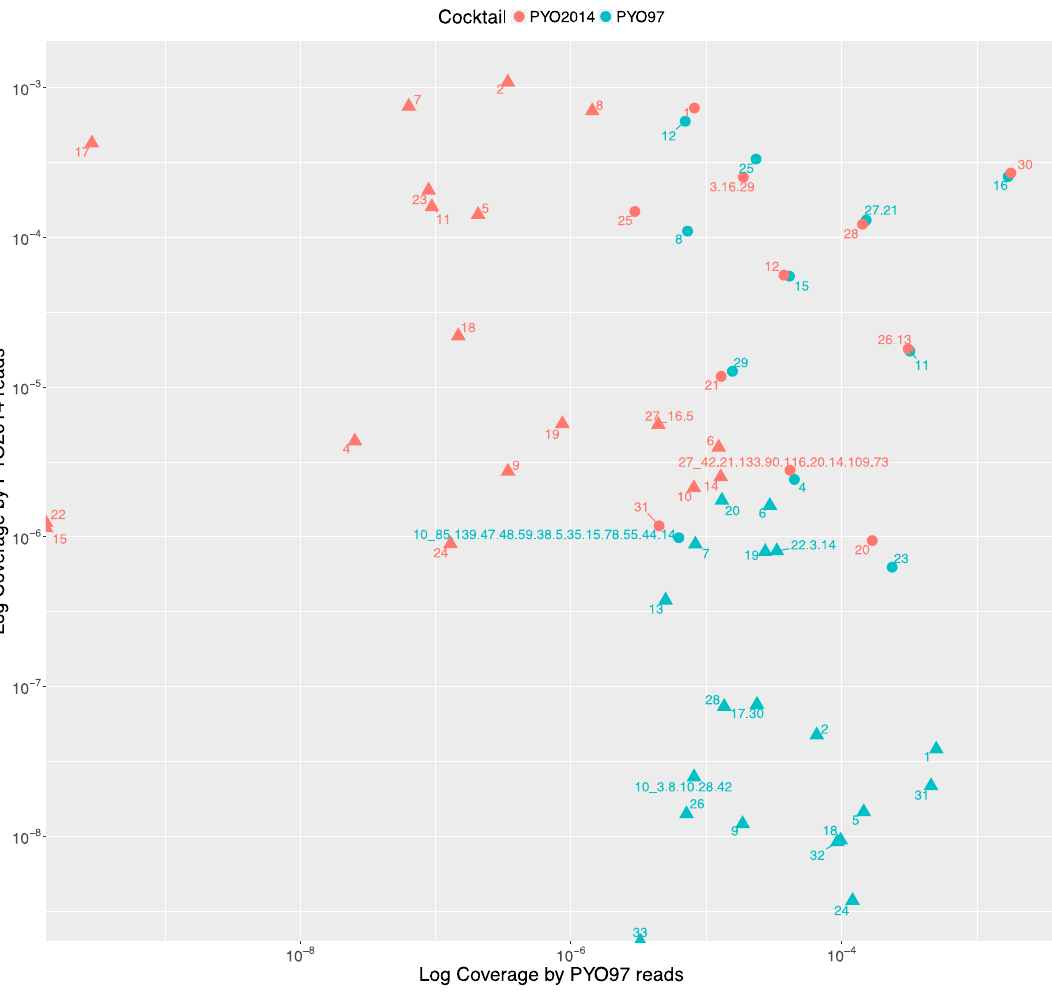
Figure 4. All the bins from PYO97 and PYO2014 are plotted according to the Log to base 10 of the coverage by PYO97’s reads, x-axis and PYO2014’s reads, y-axis. Bins from PYO97 are depicted in blue, whilst bins from PYO2014 are red. Circle shaped data points represent pairing bins between the two samples, i.e., bins for which MetaPhinder found a matching counterpart in the other sample with a ANI > 70%; see Table 6 and Material and Methods, Estimate similarities between PYO97 and PYO2014 . The bottom right corner of Figure 4 is populated by PYO97’s bins with low bin coverage by PYO2014’s reads, whilst the top left clusters PYO2014’s bins with low bin coverage by PYO97’s reads. The bins in these two parts of the figure are thus most likely phages added (top left corner) or removed (lower right corner) when constructing the cocktails at the two time points: 1997 and 2014.